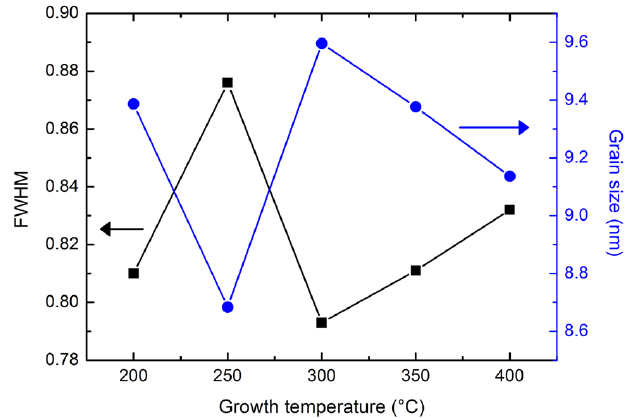
Figure 4. Grain size distribution and FWHM variation of the 1.0 wt.% WZO films grown at 200 – 400 °C.